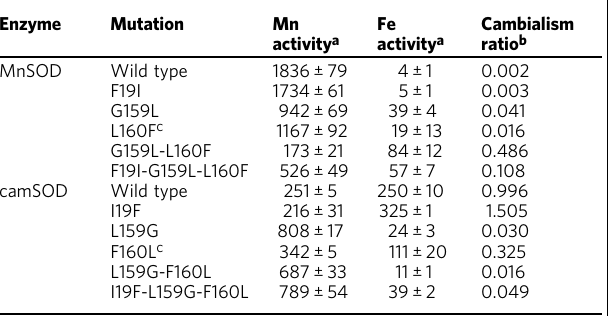
Table 1 Enzymatic activity of all SOD forms from this study. Enzyme Mutation Mn